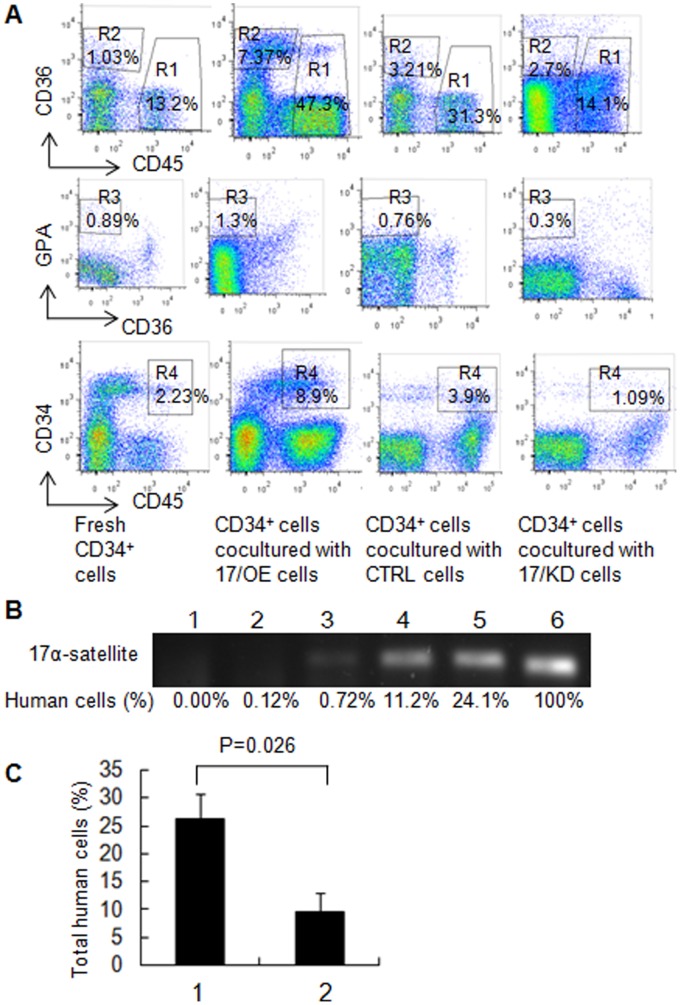
Effect of miR-17 modulation on repopulation of CD34+ cells in primary and secondary NOD/SCID mice.A: Flow cytometry analysis of the human CB CD34+ cell repopulation in a representative primary NOD/SCID mouse after co-cultured with 17/OE, 17/KD or CTRL cells. Fresh CD34+ cells were served as controls. The mononuclear cells from bone marrow harvested from the engrafted NOD/SCID mice were examined by flow cytometry for the assessment of human cells composed of CD45+ cells (R1) and erythroid cells including CD45–CD36+ (R2) and CD36–GPA+ (R3) population and CD45+CD34+ cells (R4). B: The bone marrow mononuclear cells (MNCs) containing the different percentage of human cells (lanes 2-5) from the primary representative engrafted mice were analyzed for human-specific 17α-satellite DNA by PCR. The human-specific 17α-satellite gene was detected when the human cells were over 0.70% (lanes 3–6) whereas it was indetectable at a percentage of 0.12% (lane 2). Lane 1, one mouse without transplants; lane 2, one mouse receiving transplants of fresh CD34+ cells; lane 3, one mouse receiving transplants of CD34+ cells co-cultured with 17/KD cells; lane 4, one mouse receiving transplants of CD34+ cells co-cultured with CTRL cells; lane 5, one mouse receiving transplants of CD34+ cells co-cultured with 17/OE cells; lane 6 indicates positive control (human peripheral blood (PB) MNCs). C: Effect of miR-17 modulation in FBMOB-hTERT cells on repopulation of CB CD34+ cells in secondary NOD/SCID mice. Human cells were analyzed in secondary mice 12 weeks after intravenous injection of bone marrow cells from primary mice, which were injected with CB CD34+ cells co-cultured with 17/OE or CTRL for 4 weeks and sacrificed 8 weeks after transplantation. P = 0.026, compared between 1 and 2 (1, bone marrow mononuclear cells in secondary mice from primary mice injected with CB CD34+ cells co-cultured with 17/OE; 2, bone marrow mononuclear cells in secondary mice from primary mice injected with CB CD34+ cells co-cultured with CTRL) (Student’s t-test).